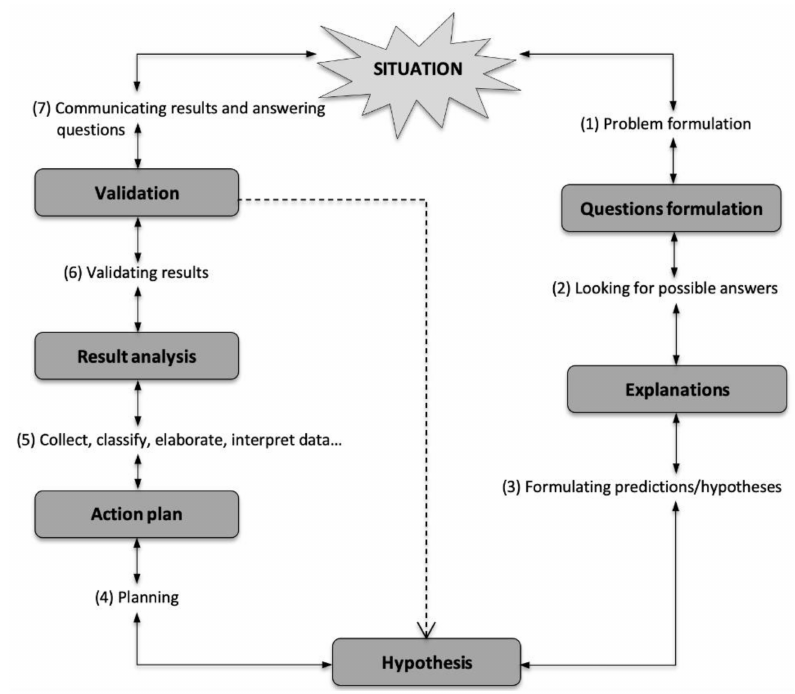
Figure 3. Inquiry process model ([28], p.